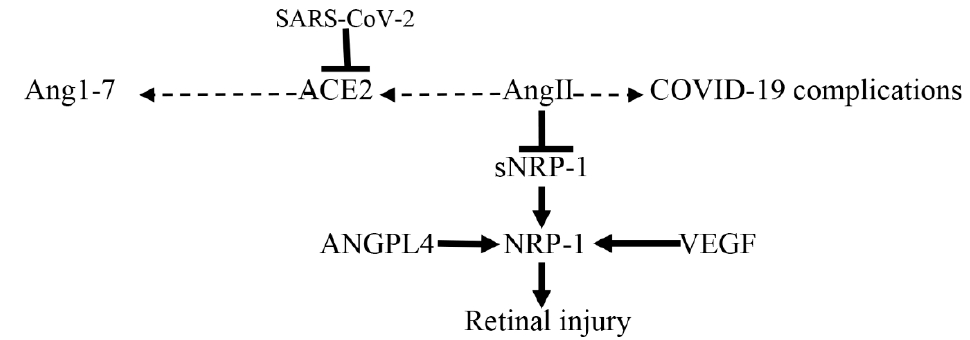
Figure 11. Role of neuropilin 1(NRP-1) in retinal injury in COVID-19: SARS-CoV-2 infection down- regulates angiotensin-converting enzyme 2 (ACE2), increases angiotensin II (AngII), which inhibits soluble NRP-1(sNRP-1), leading to increased expression of NRP-1. In retinal tissue, vascular endothelial growth factor (VEGF) and angiopoietin-like peptide 4 (ANGPTL4) activate retinal NRP-1 receptors leading to retinal injury.